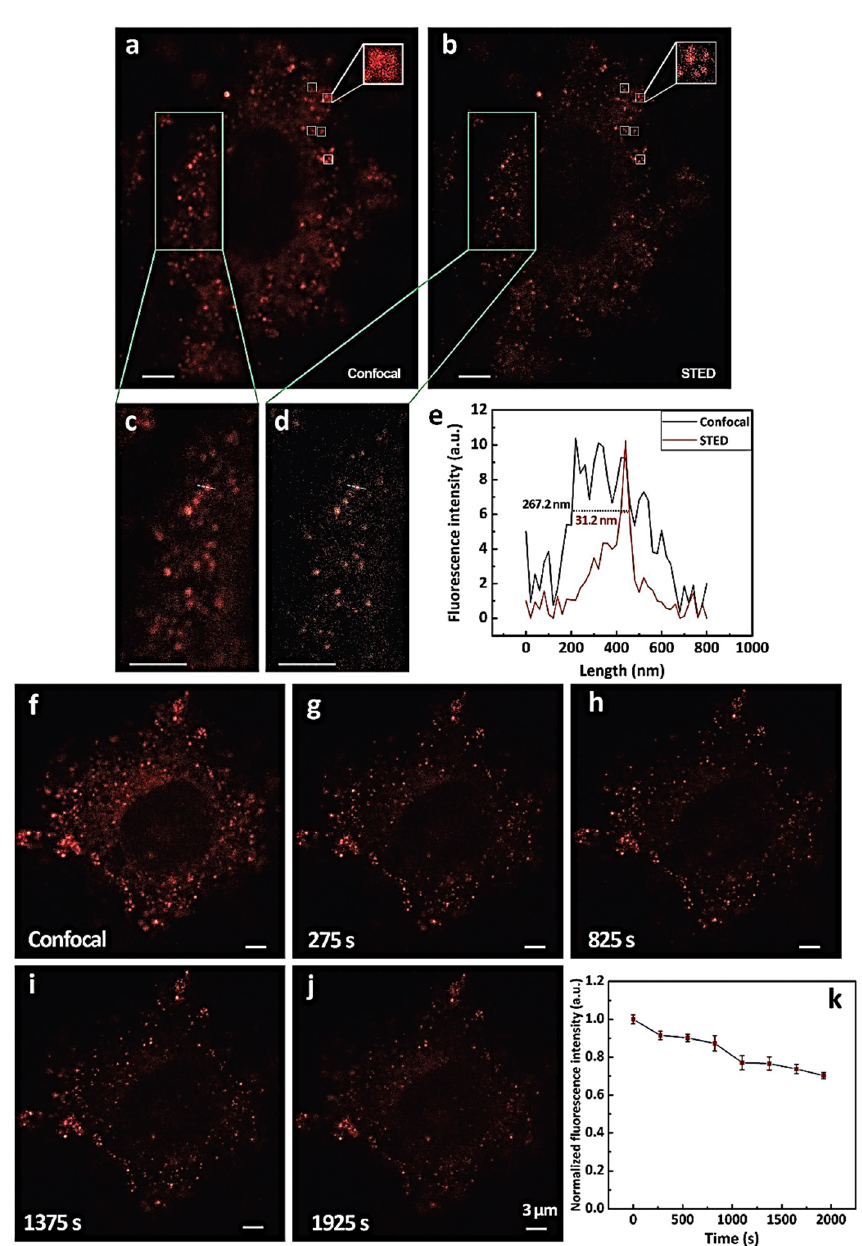
Figure 13. Fluorescence images of HeLa cells stained with TTF@SiO 2 NPs observed under confocal microscopy and STED nanoscopy imaging. ( a , b ) Confocal and STED nanoscopy images of cells incubated with TTF@SiO 2 NPs while ( c , d ) represents the magnified fluorescent image of ( a , b ). ( e ) The fluorescence intensity recorded by confocal (black) and STED (red). ( f ). The image demonstrates the confocal microscopy image for TTF@SiO 2 NPs for HeLa cells and from ( g – j ) STED nanoscopy images captured at different time points for HeLa cells. ( k ) The normalized fluorescence intensity for HeLa cells incubated with TTF@Si 2 NPs at different time points. Reprinted from reference [88] with permission from Wiley-VCH.